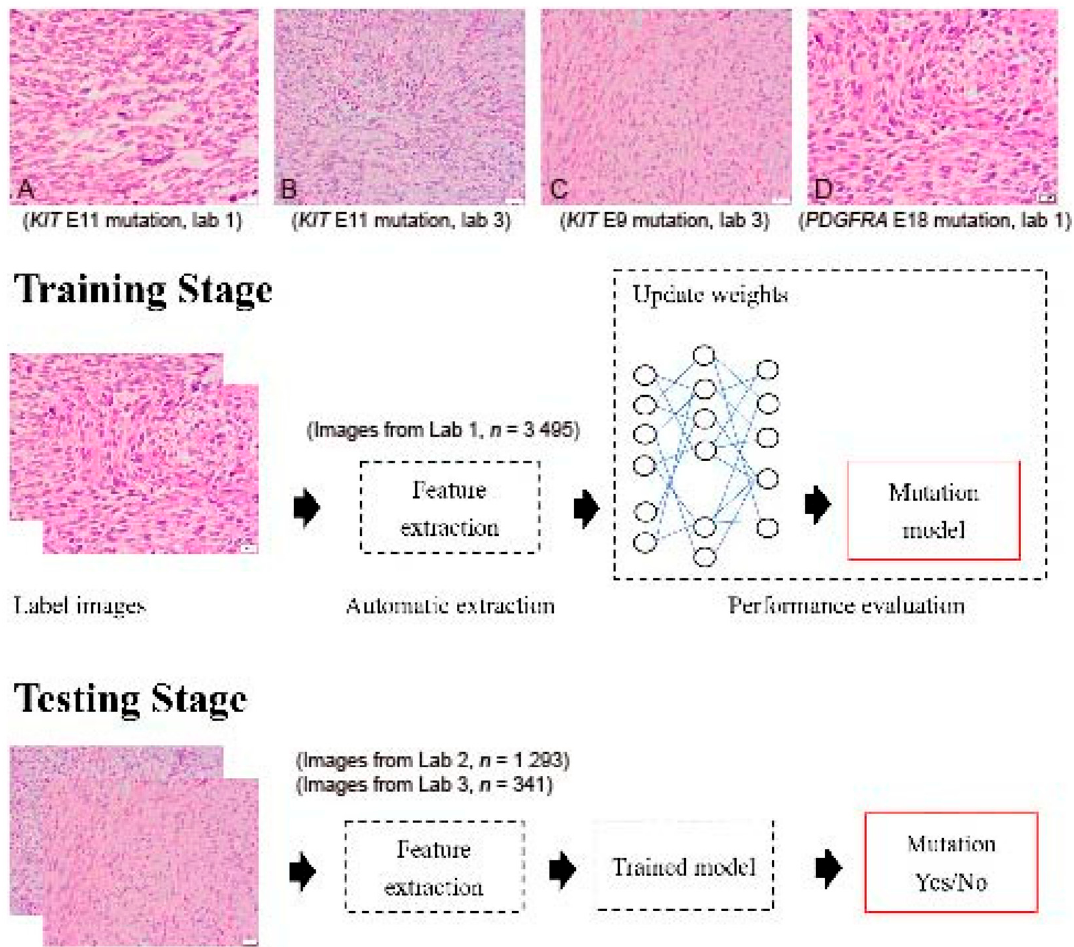
Figure 1. Flowchart of the implemented deep convolutional neural network. Images were collected from 3 independent laboratories (Lab 1, Lab 2, and Lab 3) using 4 µ m thick, hematoxylin-and-eosin slides. ( A ) An example image of a GIST with a KIT exon 11 mutation from Lab 1 (400 × ). ( B ) An example image of a GIST with a KIT exon 11 mutation from Lab 3 (400 × ). ( C ) An example image of a GIST with a KIT exon 9 mutation from Lab 3 (400 × ). ( D ) An example image of a GIST with a PDGFRA exon 18 mutation from Lab 1 (400 × ). Although similar staining protocols were used, the overall hue differs between laboratories. A total of 5129 images were enrolled in the study. Four different DCNNs, AlexNet, InceptionV3, ResNet, and DenseNet, were used with transfer learning from ImageNet. The transferred DCNN model generated the probability that each image contained a drug-sensitive mutation. A probability higher than 0.5 was regarded as positive. The dataset was randomly separated into 10 equal-sized subsets. In each iteration, one subset was picked and used to test the trained model on the remaining nine